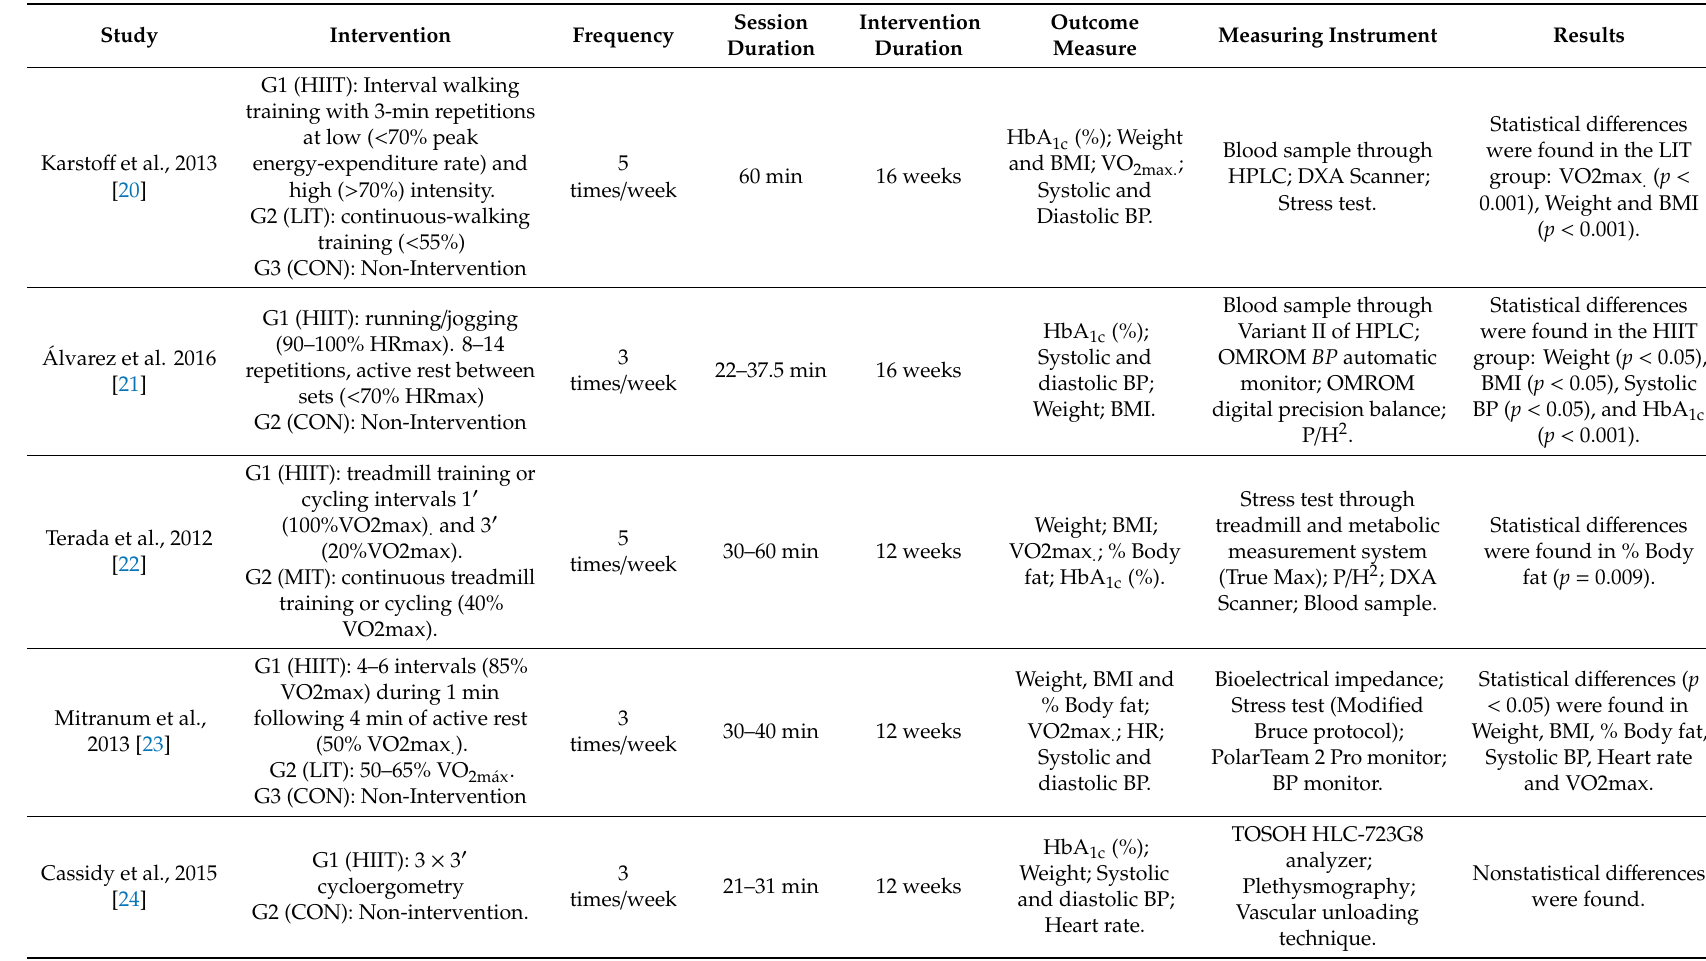
Table 3. Main characteristics of the study